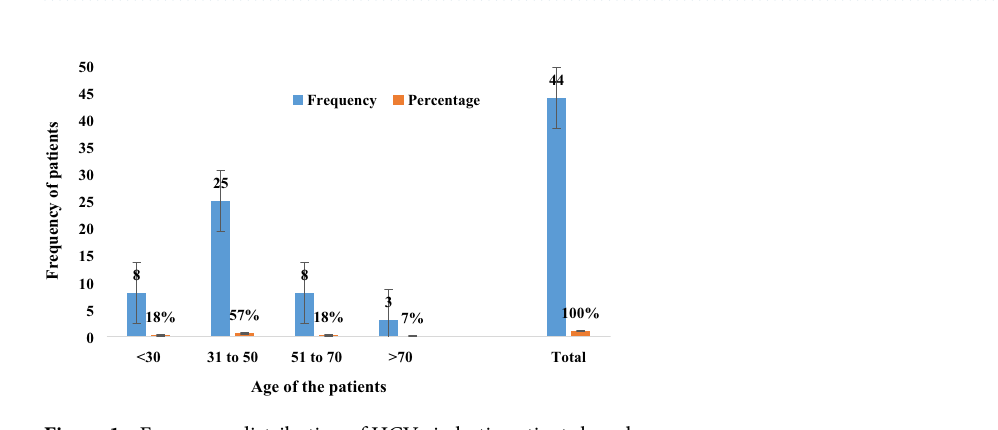
Table 2. Baseline characteristics of HCV cirrhotic patients (n = 44). SD standard deviation, ALT alanin transaminase, AFP alpha fetoprotein, AST asparagine transaminase.